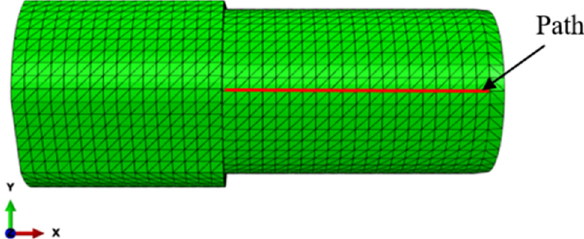
Figure 6: The path for contact surface stress output.